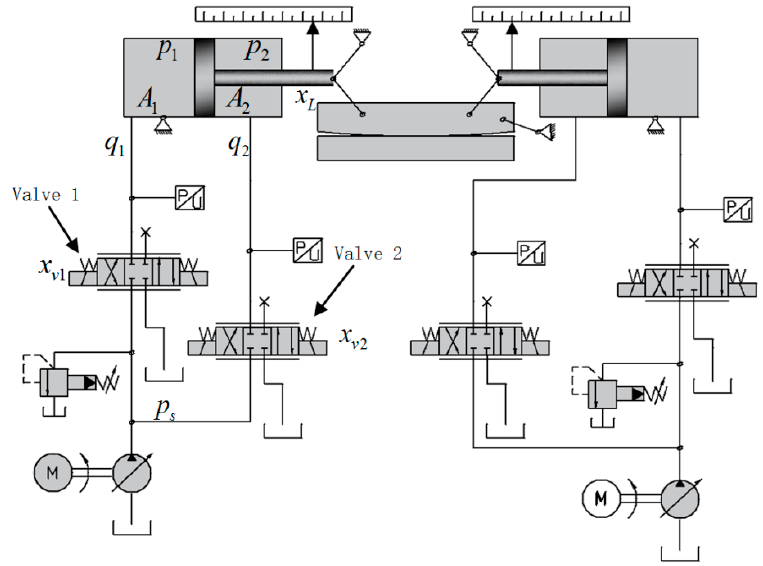
Figure 4. Schematic of the proposed electro-hydraulic servo system.